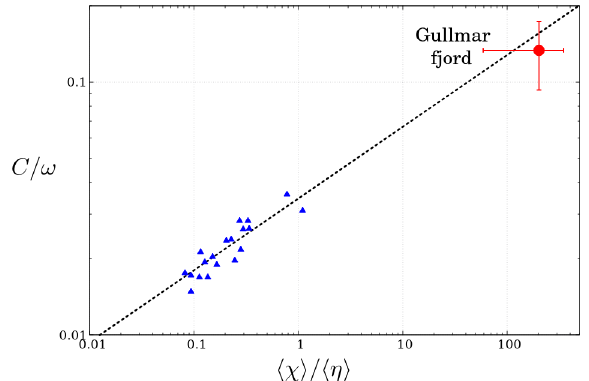
Figure 10. Nondimensional decay coefficients as a function of py- cnocline vs. surface average displacement ratios for laboratory ex- periments (blue triangles) and for the Gullmar fjord (red circle). The dashed line represents the power law fit of C/ω = ( 0 . 035 ± 0 . 002 ) · ( (cid:104) χ (cid:105) / (cid:104) η (cid:105) ) 0 . 28 ± 0 . 04